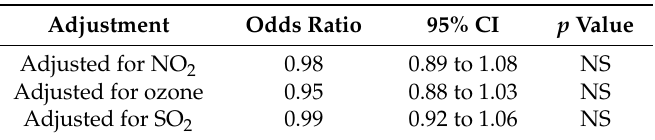
Table 5. Estimated effects of AD particles on skin symptoms in the two-pollutant model after adjustment for NO 2 , ozone, and SO 2